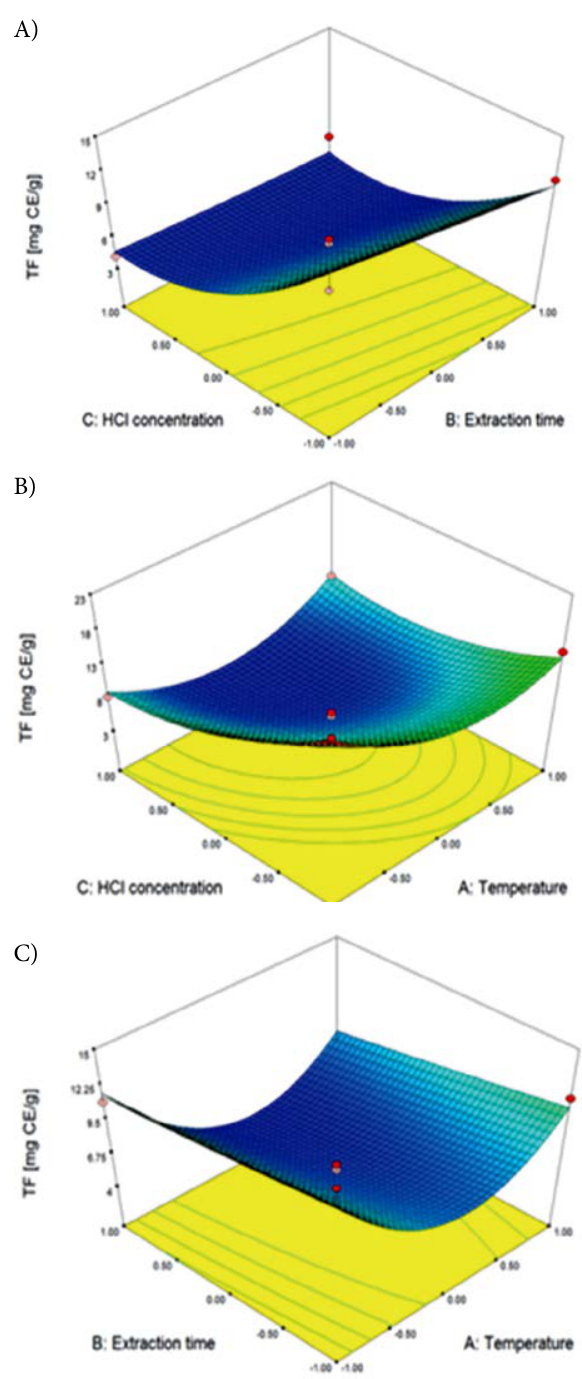
C)A) Figure 3 Response surface plots showing combined effects of pro- cess variables: (A) HCl concentration and extraction time, (B) HCl concentration and temperature and (C) extraction time and tem- perature on total flavonoids content